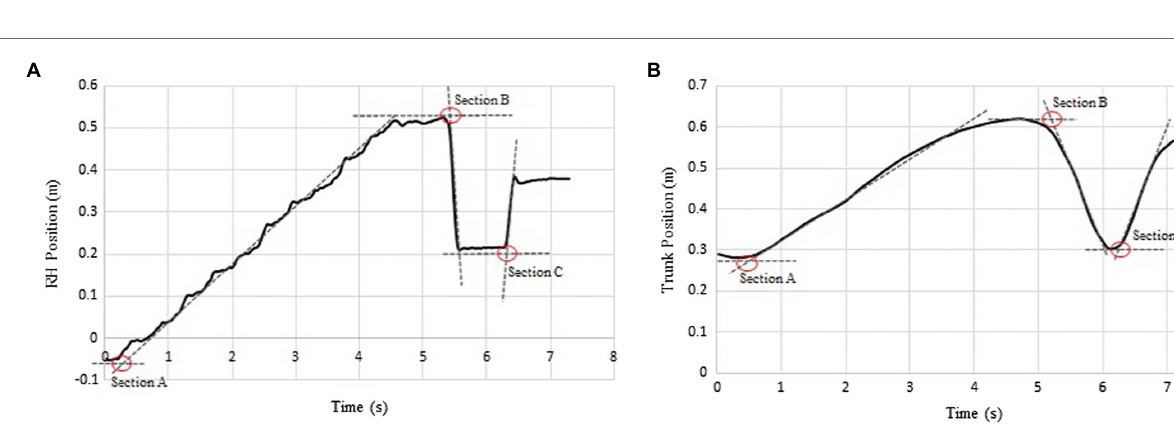
FIGURE 2 | The experimental set-up of the motion capture system in the concert hall.